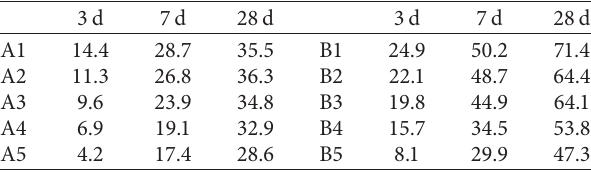
Table 4: Compressive strength of C30 and C50 concrete (MPa).